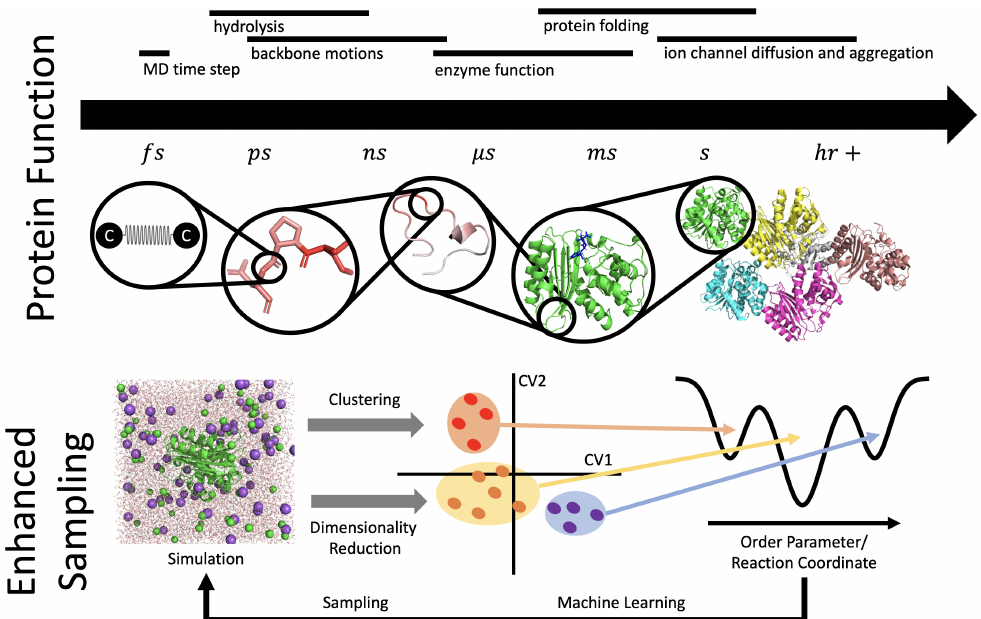
Figure 4. Time scales of protein function. Protein function occurs on time scales that span many orders of magnitude. MD simulation time steps are limited to the femtosecond range, necessitating enhanced sampling methods for the analysis of long time scale processes. Enhanced sampling typically starts with an unsupervised simulation of proteins to initially explore conformation space. Clustering and dimensionality reduction inform methods such as metadynamics on how to bias further simulations for the exploration of unsampled or poorly sampled regions in the free-energy landscape. Machine learning has been deployed to achieve better and faster sampling of this